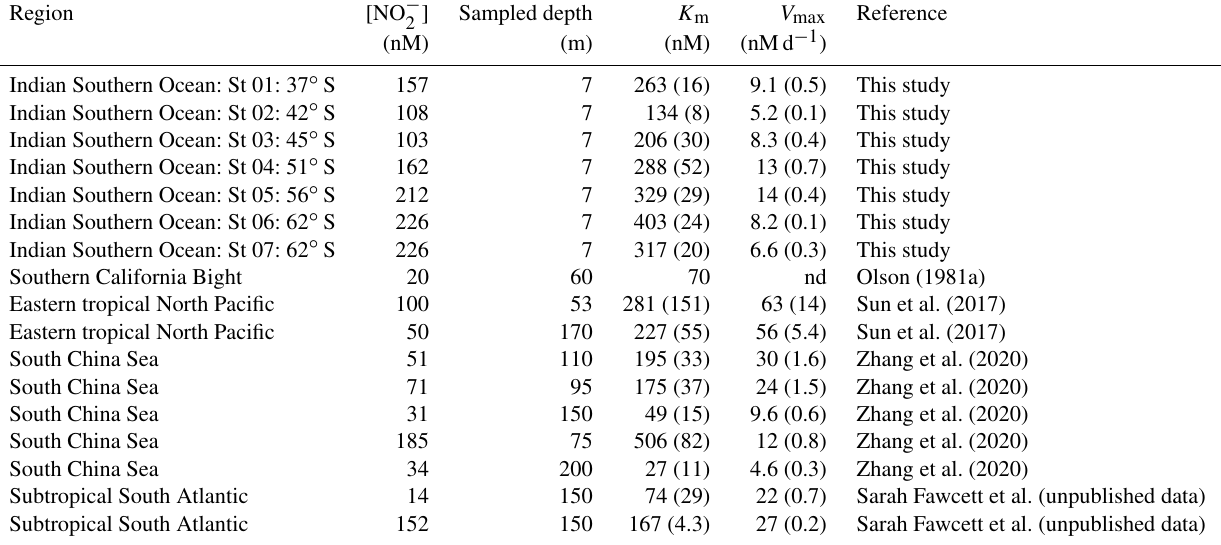
Table 2. A selection of previously derived K m and V max values from the open ocean, along with the concurrently measured ambient concentrations of nitrite ([NO − ] amb ) . The numbers in parenthesis are standard errors. 2